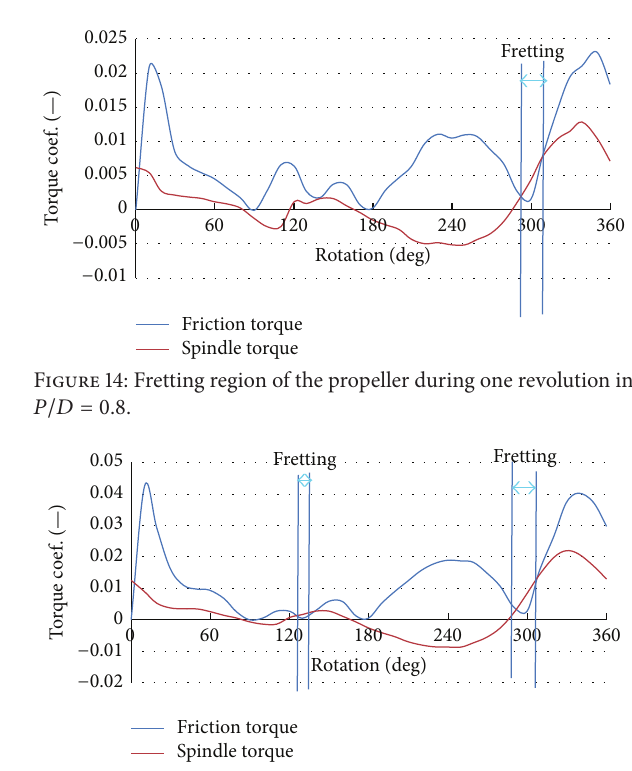
Figure 15: Fretting region of the propeller during one revolution in 𝑃/𝐷 = 1.1 .